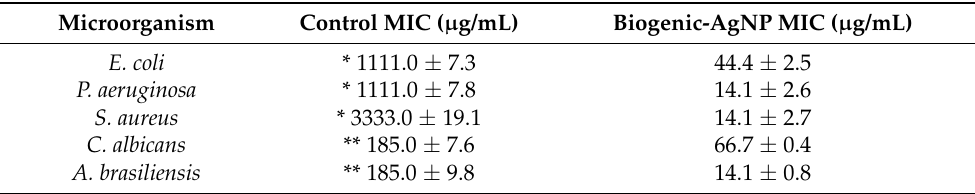
Table 2. Minimum inhibitory concentrations ( µ g/mL) of control drugs (Gentamicin (*) and Tebu- conazole (**)) and Biogenic-AgNPs.